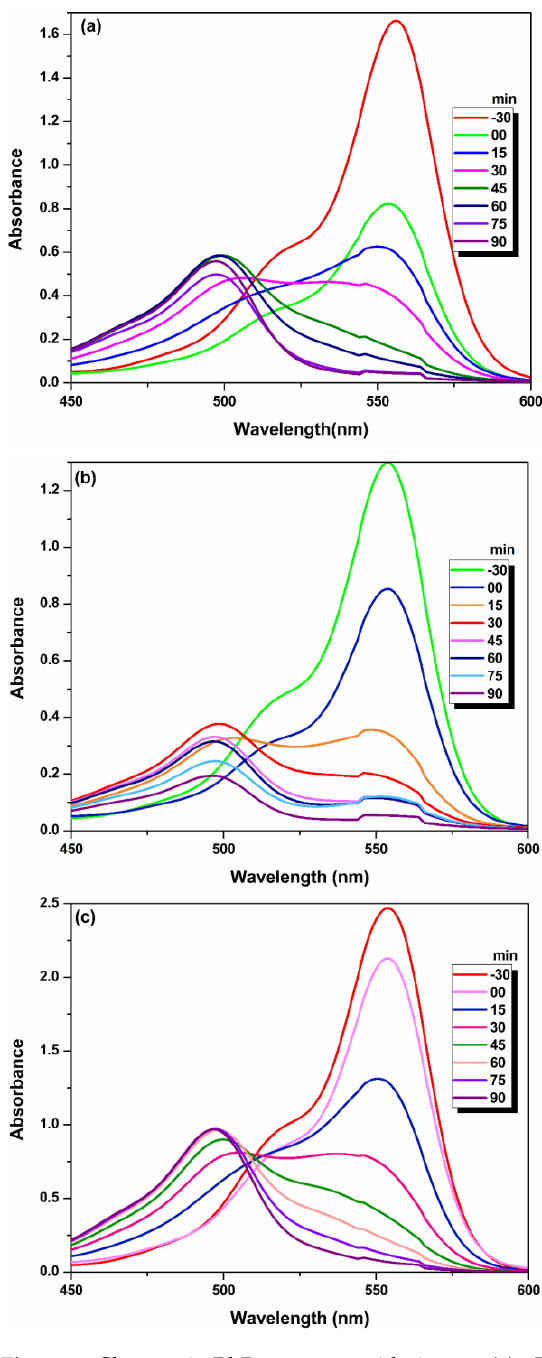
Figure 5. Changes in RhB spectrum with time, at ( a ) pH 3, ( b ) pH 7 and ( c ) pH 10.